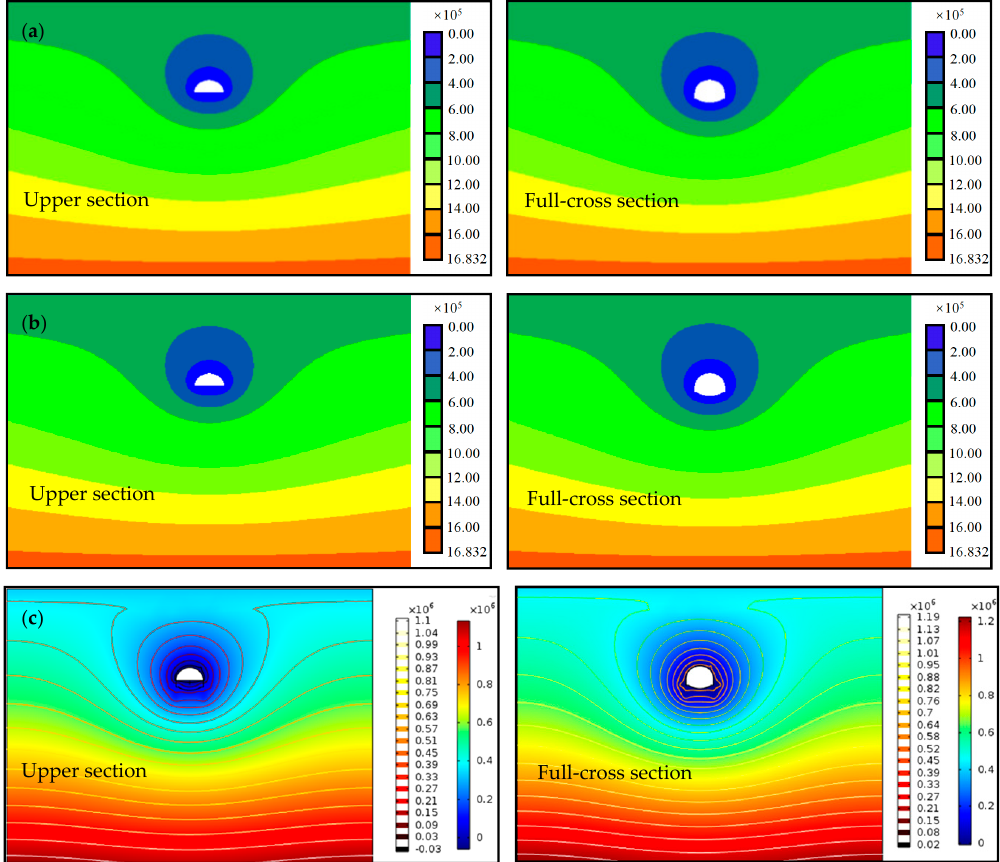
Figure 17. The distribution diagrams of seepage field of surrounding rock calculated by using ( a ) exploration permeability coefficient (EPC), ( b ) initial permeability (IPC), ( c ) permeability coefficient under blasting vibration (PCuBV).